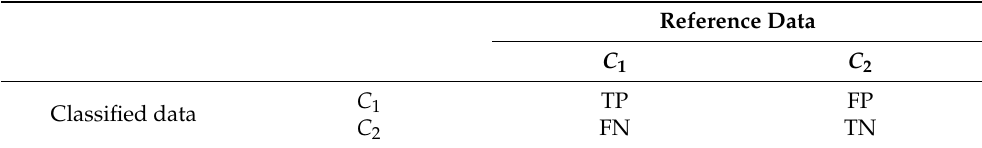
Table 2. A confusion matrix. TP is the number of correctly classification C 1 pixels. FN is the number of undetected C 1 pixels. FP is the number of incorrectly extracted C 1 pixels. TN is the number of correctly rejected C 2